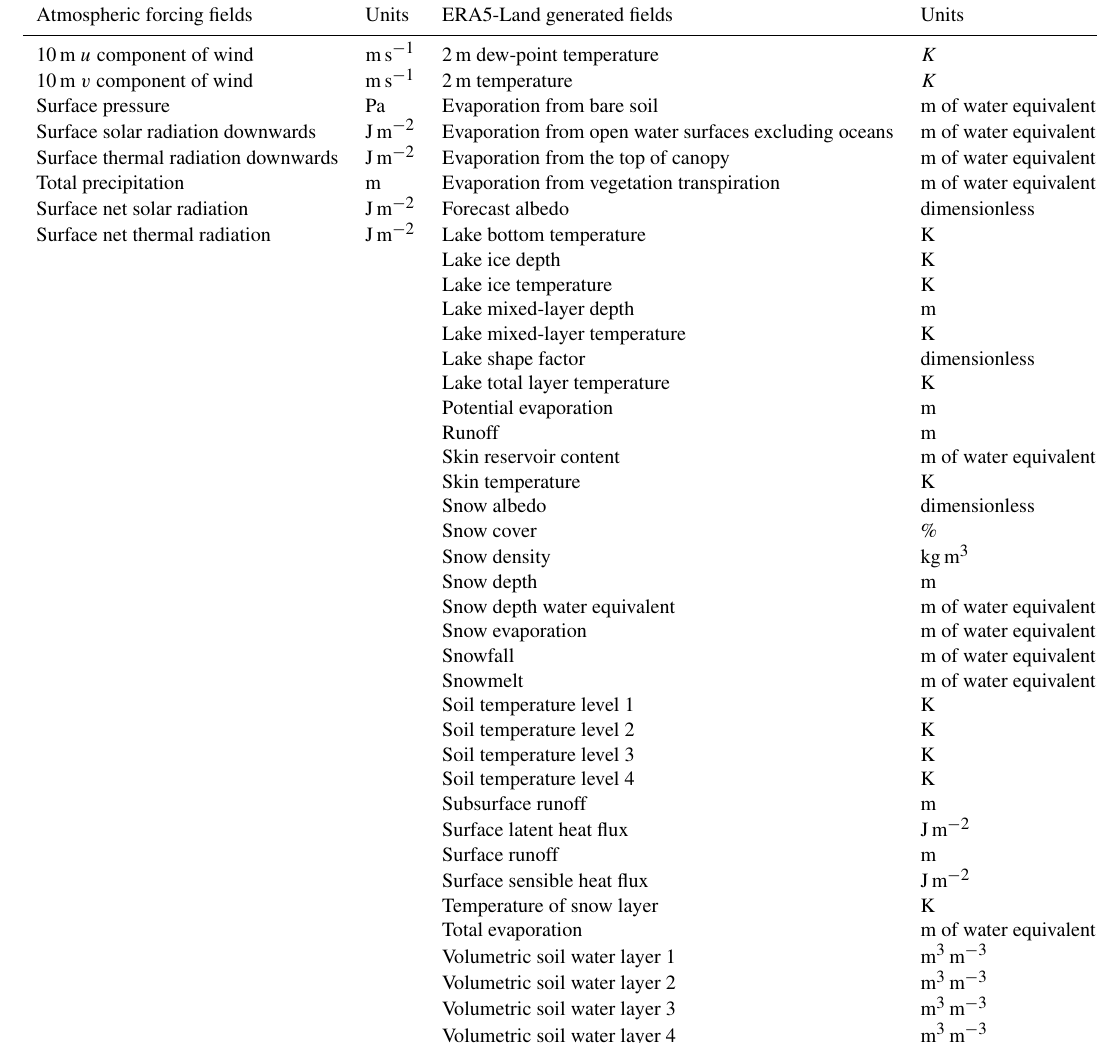
Table A2. Portfolio of ERA5-Land data fields available through the Copernicus CDS. The left column shows the atmospheric forcing fields from ERA5 that have been interpolated to the ERA5-Land spatial resolution. The right column shows all fields generated by ERA5-Land. A short description of each field is available in the CDS (Muñoz-Sabater, 2019a,